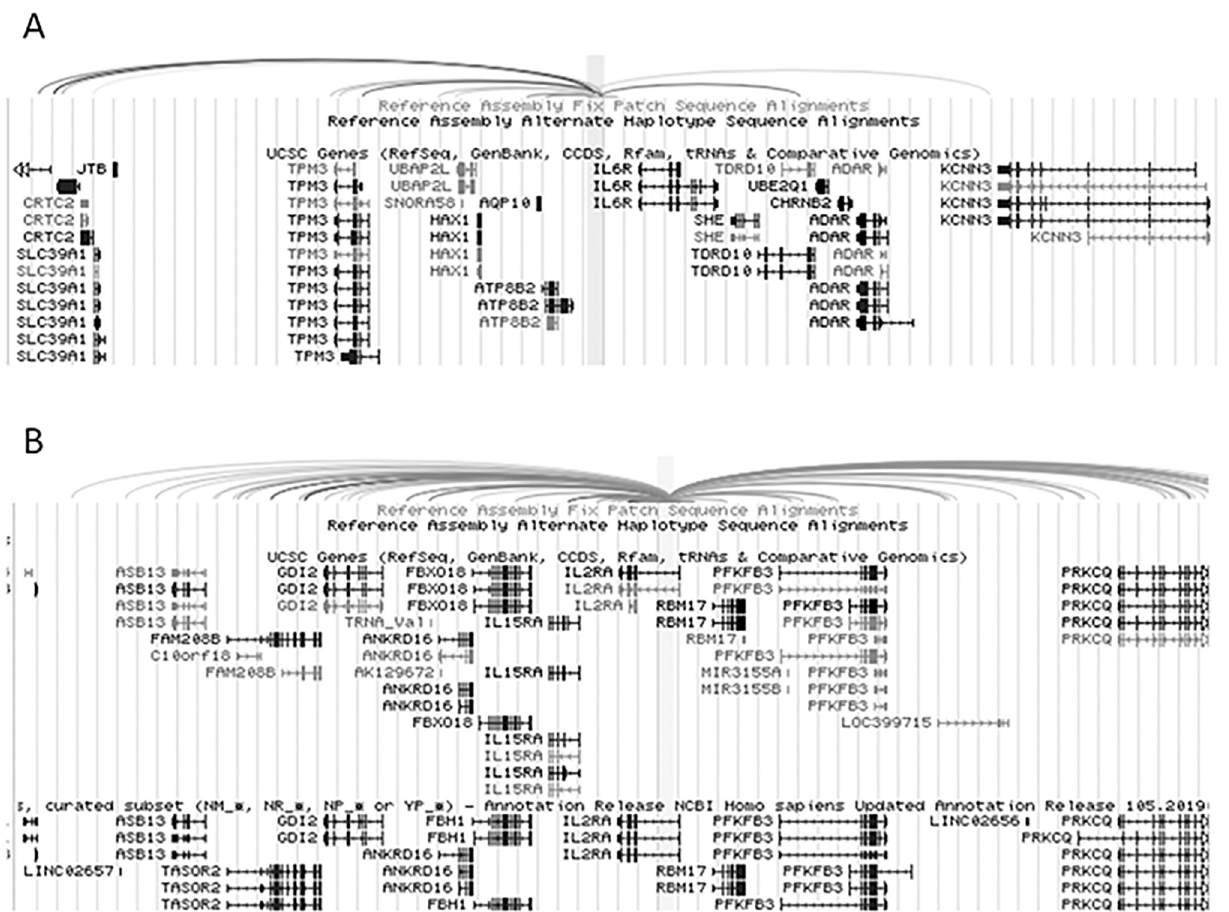
Fig 8. Genome browser screen shot showing results from promoter capture HiC data in unfractionated human peripheral blood CD4+ T cells [25]. H3K27ac-marked regions within the IL6R (A) and IL2RA (B) risk haplotypes form contact loops with multiple genes, including genes not on the risk